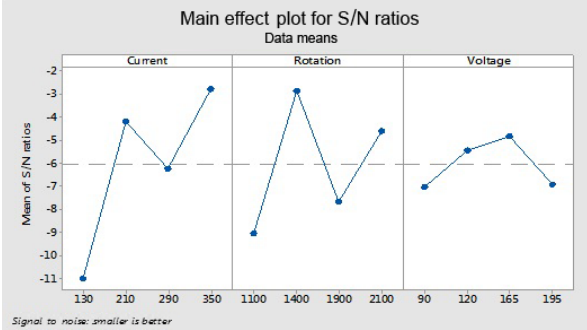
Figure 13. TWR 1 S/N graph for the cryogenic